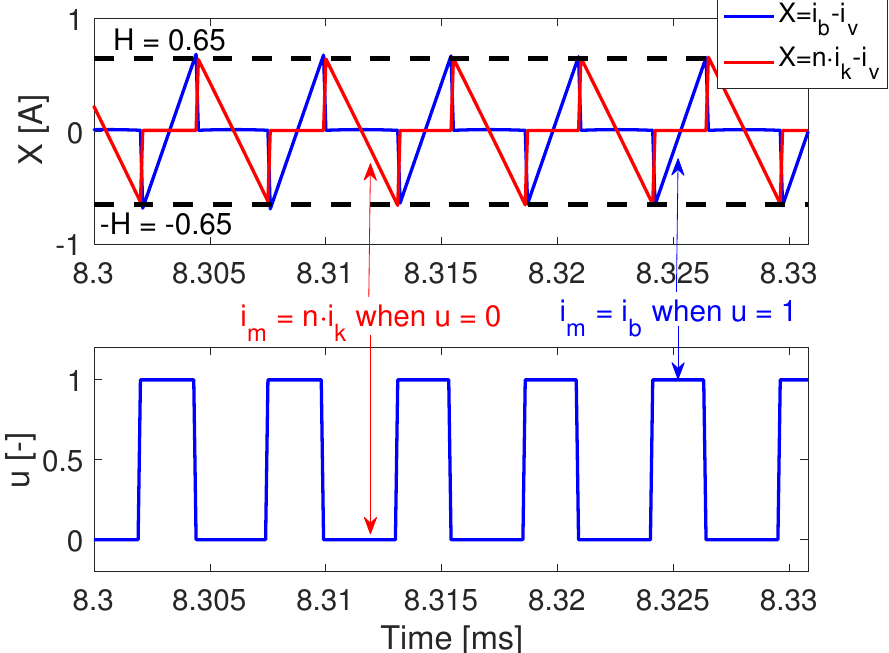
Figure 7. Control law